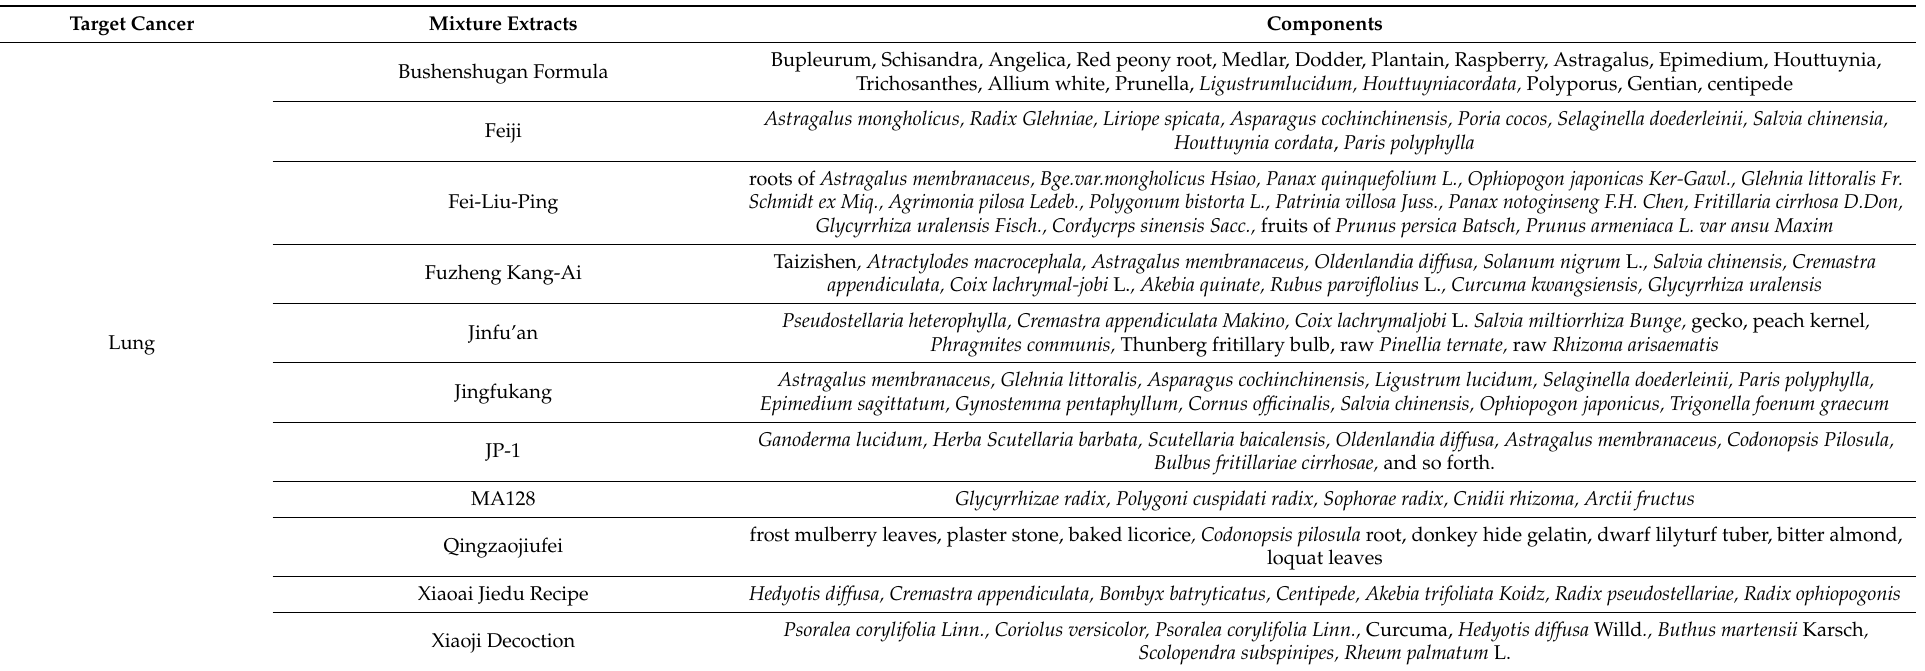
Table 7. Components of Mixture